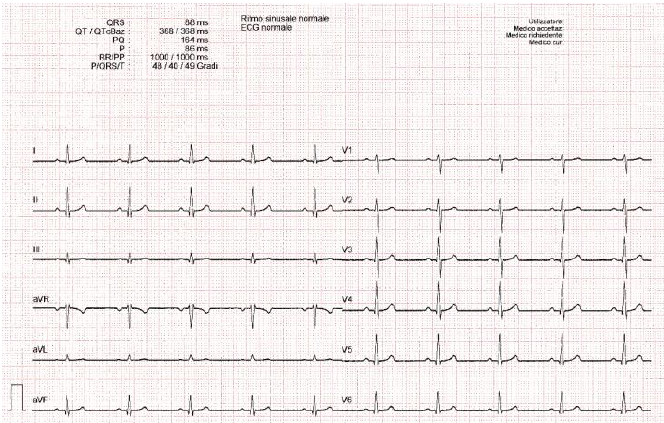
Figure 6. Thinned signal image (normal sinus rhythm, 60 bpm, II lead). C. Scale Factor (SF) calculation . The standard ECG leads are printed on graph paper (see Figure 7).